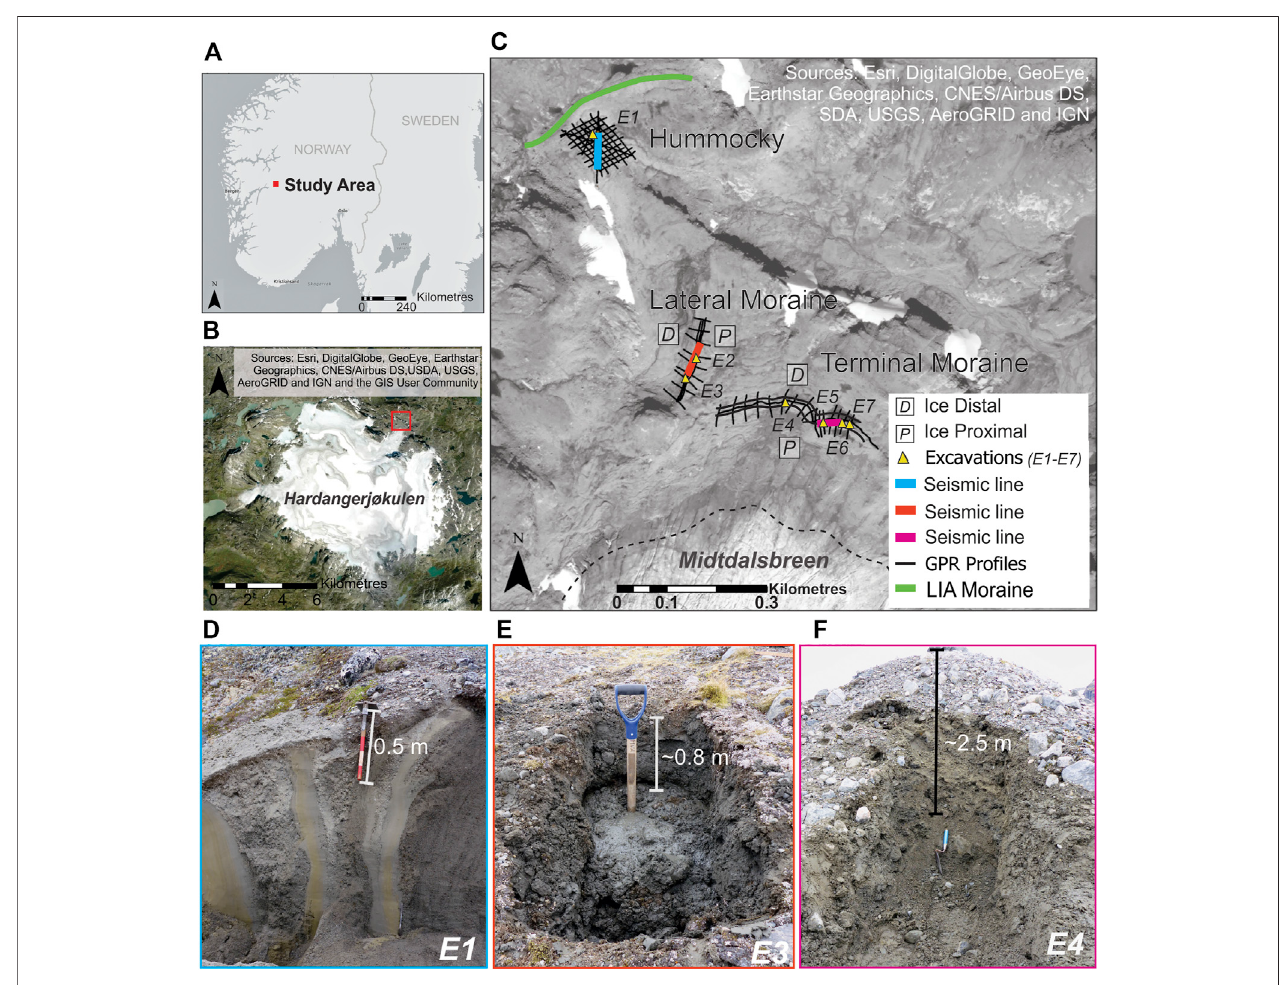
FIGURE 1 | (A) Study area location within Norway, red marker, (B) Satellite image of Hardangerjøkulen with the location of C outlined in red, (C) Satellite image of the study site showing the locations of the geophysical survey lines and sediment excavations (E1 – E7) and the approximate position of the 2018 glacier margin (dashed line).Inthispaper,GPRdataareusedtoexemplifythecharacteristicoutcomesofthetechniquesatthecontrastingsitessoonlyasubsetofthemispresented.LIA=Little Ice Age. (D) Photograph of section E1 , facing West, (E) Photograph of test pit E3 , facing South, (F) Photograph of section E4 , facing